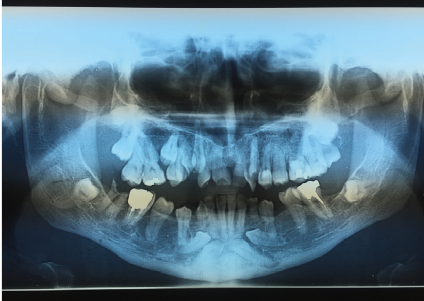
Figure 18: Case 3: radiological findings: